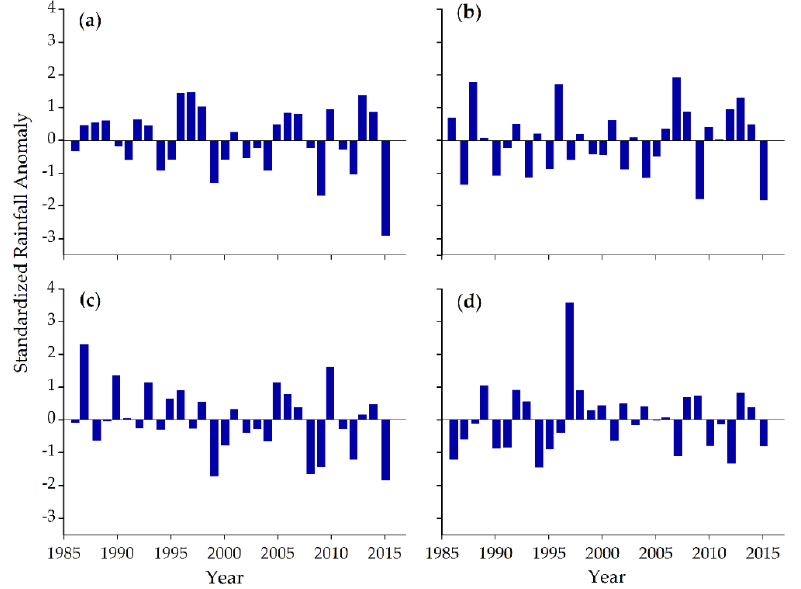
Figure 5. Standardized rainfall anomaly of the Bilate watershed for the period 1986–2015 for ( a ) the annual, ( b ) the Kiremt, ( c ) the Belg, and ( d ) the Bega